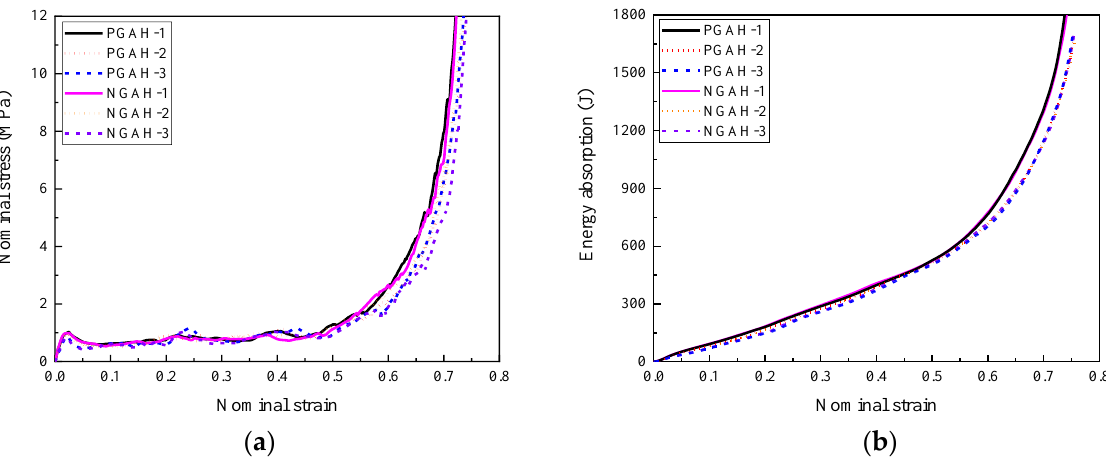
Figure 15. The stress – strain relationships and energy absorption of the composite with different cell- wall thickness gradients and gradient directions (1 m/s): ( a ) stress – strain relationships; ( b ) energy absorption.